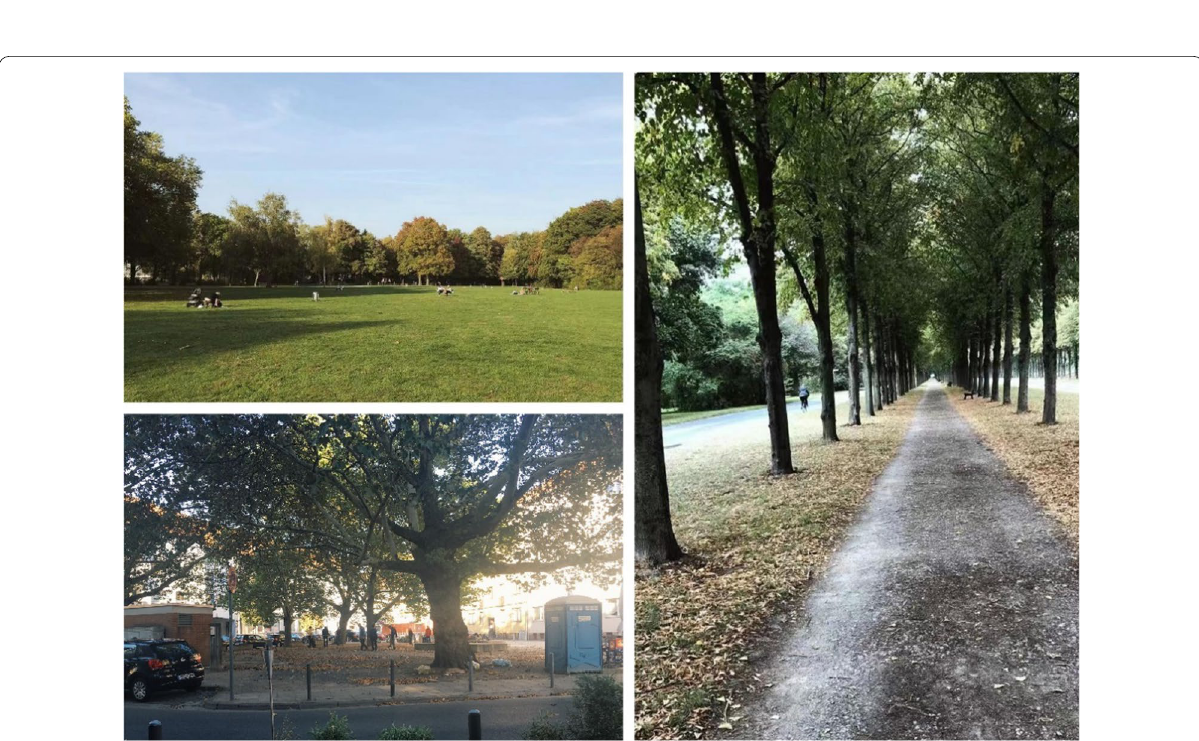
Fig. 4 Typical places for people to enjoy nature-based recreation (NBR) in Hannover. The top-left photo shows an urban forest. The bottom-left photo shows a street garden in the residential area. The right photo shows a linear greenway in the western part of the